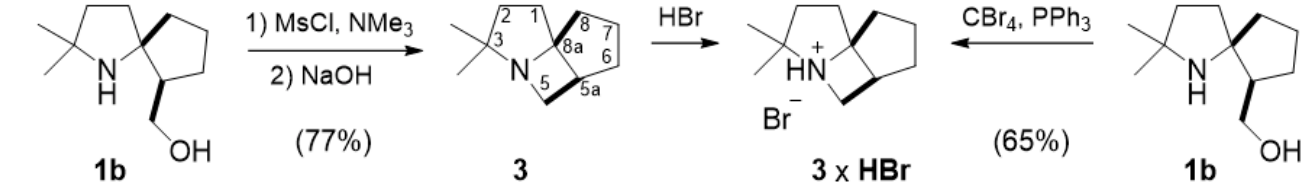
Scheme 10. Reaction of 1b with MsCl/NMe 3 or PPh 3 -CBr 4 .